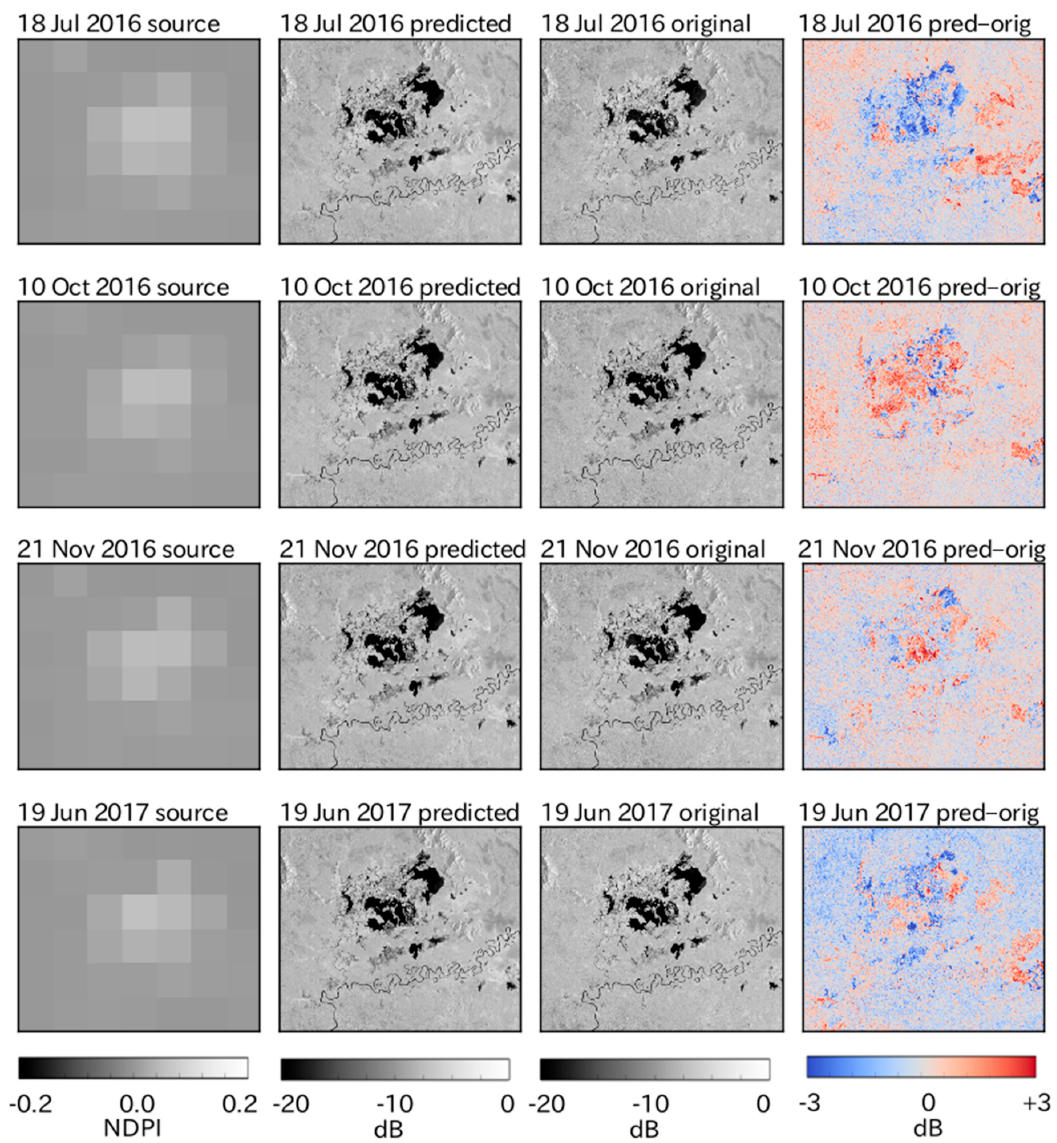
Figure 5. Image validation: good cases. The day, month and year are indicated in the title of each figure. ‘Source’ is the AMSR-2 NDPI composite image, ‘predicted’ is a prediction result of RFDBUX with the leave-one-out condition, ‘original’ is the PALSAR-2 HH σ 0 image on that day, and ‘pred − orig’ is the ‘predicted’ minus the “original”.